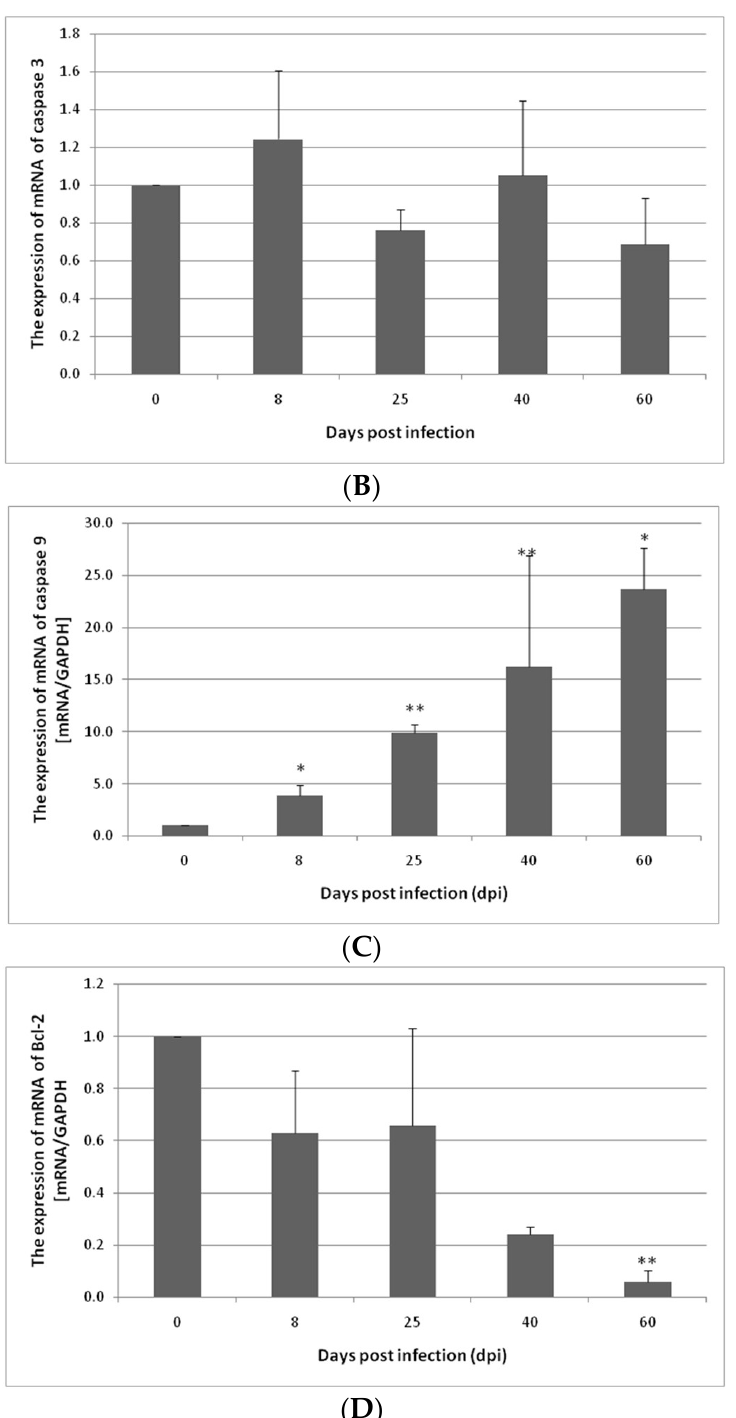
Figure 2. Expression of Bax ( A ), caspase-3 ( B ), caspase-9 ( C ), and Bcl-2 ( D ) genes at the mRNA level in the colon from uninfected and H. diminuta -infected rats. Data represent the arithmetic mean ± SD and are representative of individual groups of six animals in each experiment. Statistical analysis was performed using the Kruskal–Wallis test, * p < 0.05, ** p < 0.01 vs. 0 dpi. 3.2. Changes in Apoptotic Protein Expression in the Small and Large Intestine of the Rat during H. diminuta Infection H. diminuta infection affected the expression of apoptotic proteins in both the